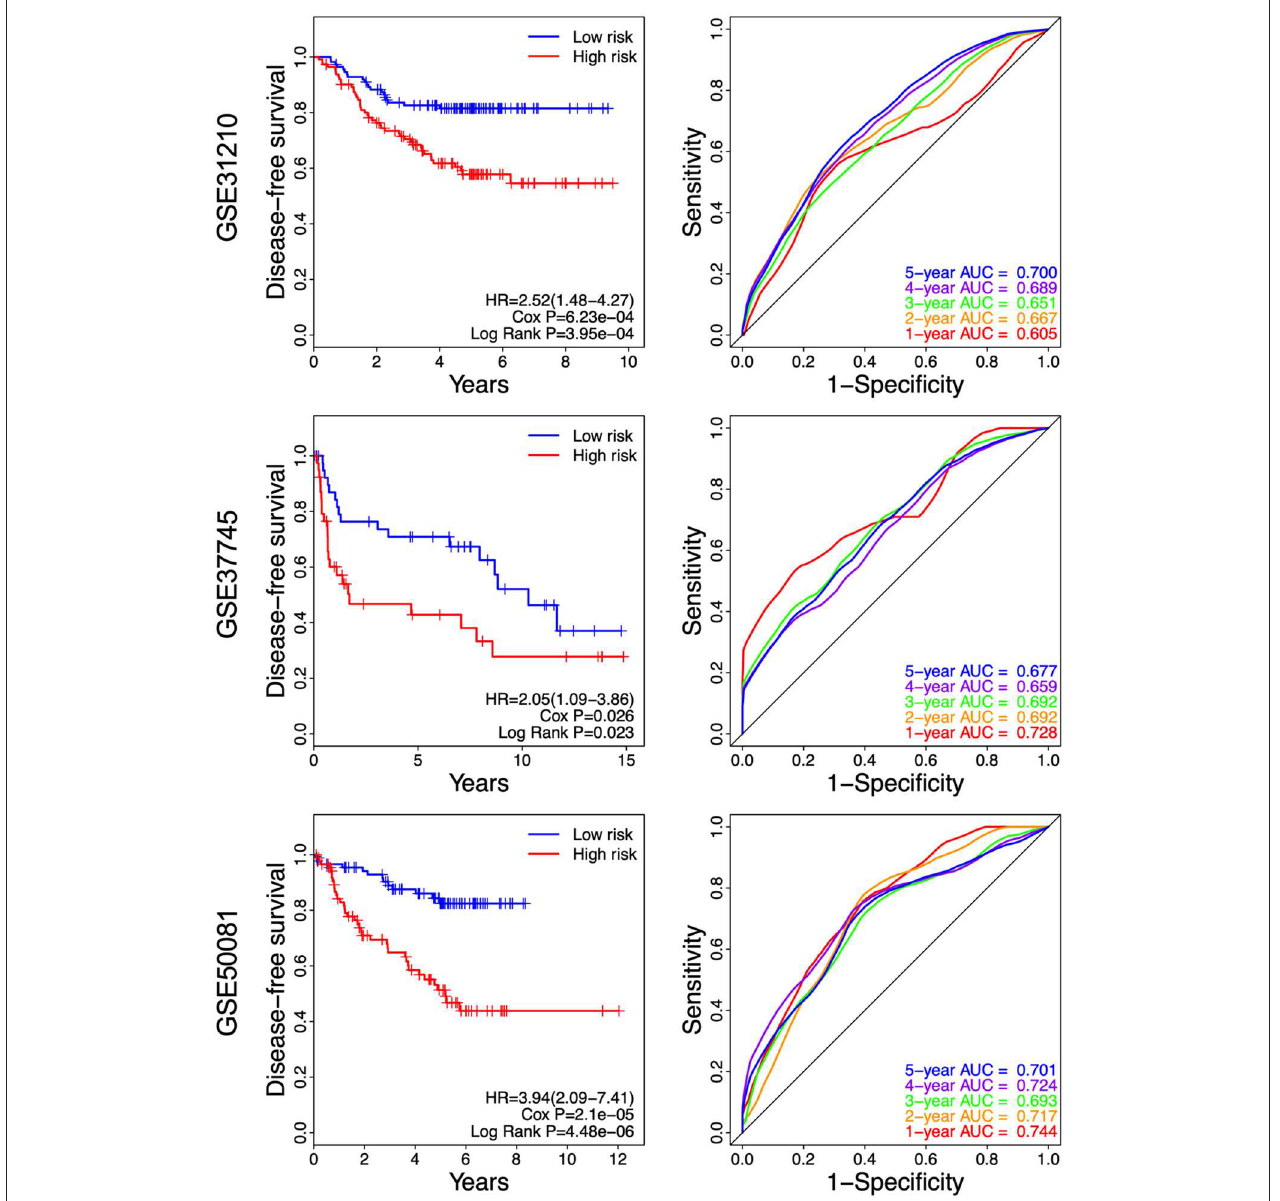
FIGURE 7 | Kaplan-Meier and ROC curves for the 8-gene signature in the three datasets. Patients in the high risk groups had shorter disease-free survival than those in the low-risk